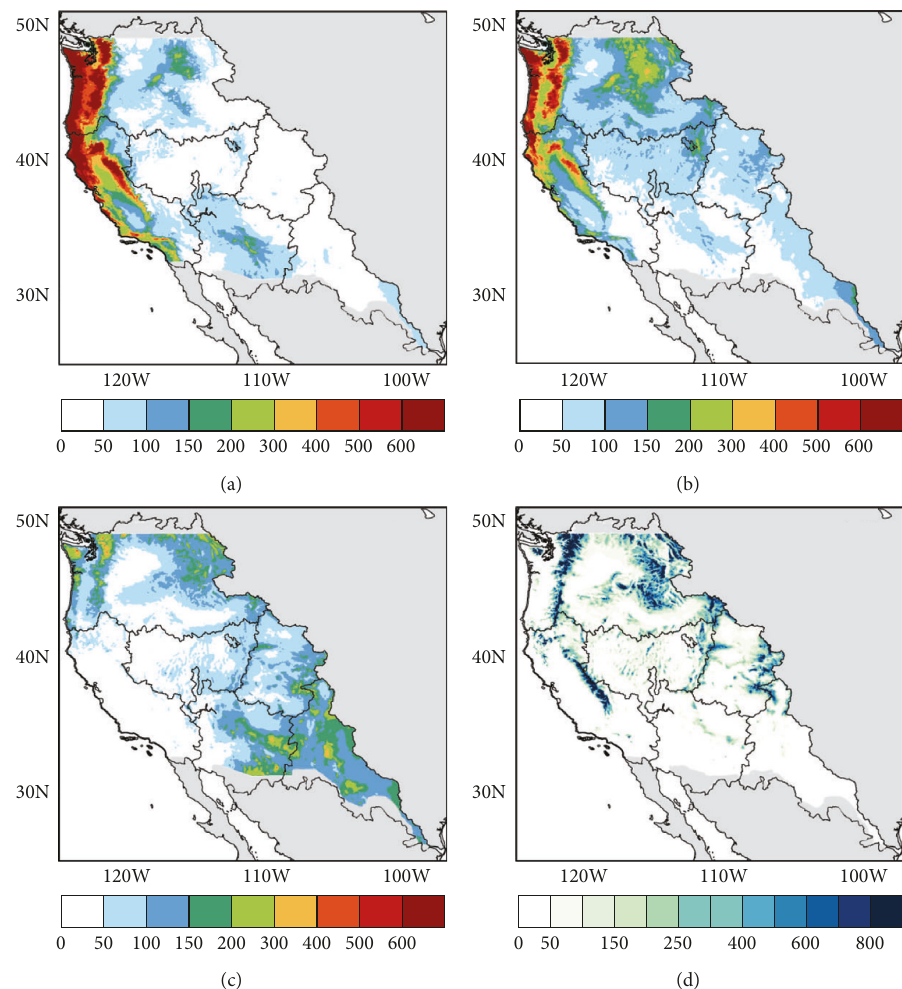
Figure 3: Mean precipitation during 1981–2016 (unit: mm): (a) winter mean rainfall, (b) spring mean rainfall, (c) summer mean rainfall, and (d) annual mean (Figure 3, RG: Jul–Sep; UC: Jul–Sep; LC: Jul–Sep; GB: Mar–May; PNW: Oct–Dec; CA: Dec–Mar). The regional